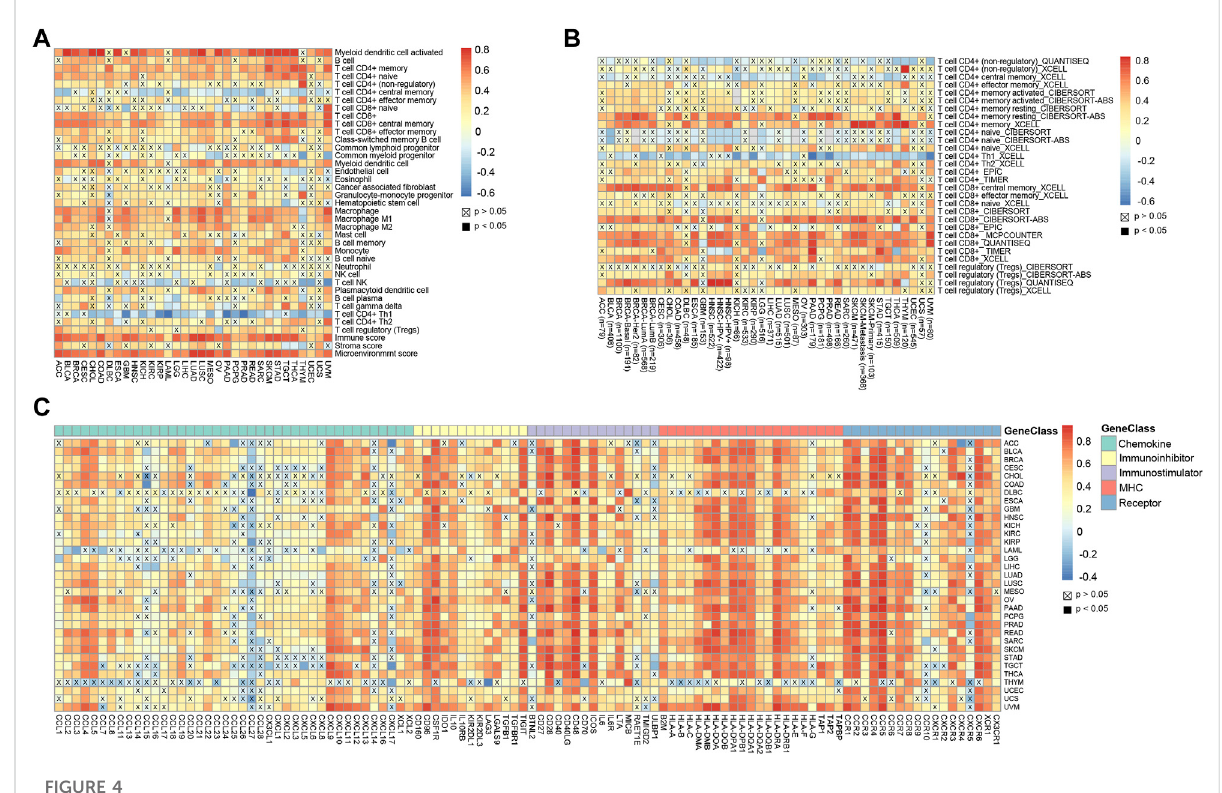
FIGURE 4 High CD45 expression correlates with immune in fi ltration across different cancers. (A) Analysis of correlation between CD45 expression and immunein fi ltration,stromalscore,immunescore,andMicroenvironmentscoreacrosscancers. (B) CD45expressionsigni fi cantlycorrelatedwiththe in fi ltration levels of various immune cells in the TIMER database. (C) Analysis of correlation between the expression level of CD45 and levels of immunomodulators across